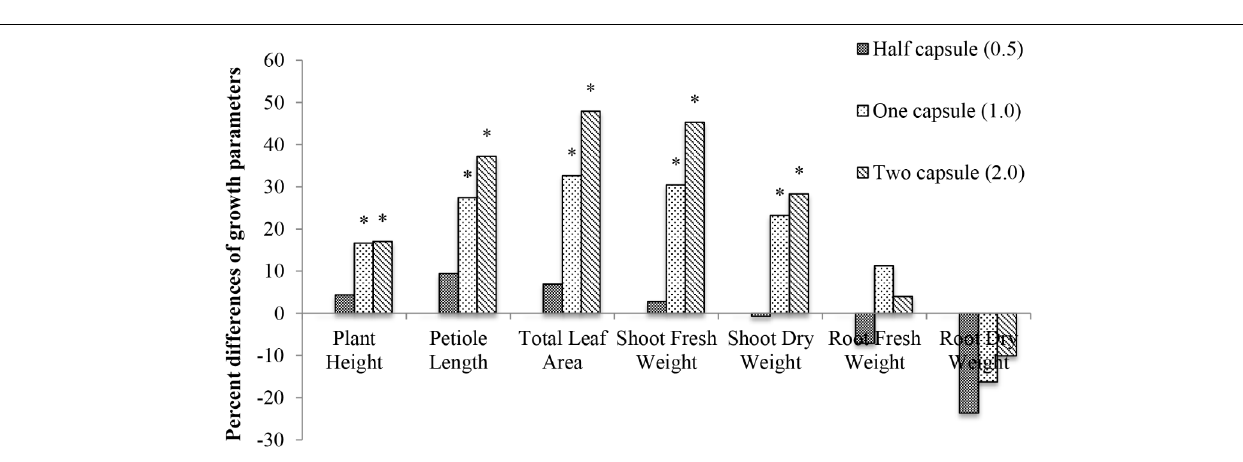
FIGURE 4 | Percent difference of seven growth parameters (plant height, petiole length, total leaf area, shoot fresh weight, shoot dry weight, root fresh weight, and root dry weight) 28 days after emergence of cucumber with three treatments: half capsule (0.5), whole capsule (1.0), and two capsules (2.0) compared to control as a base line. ∗ Denotes significance ( p <